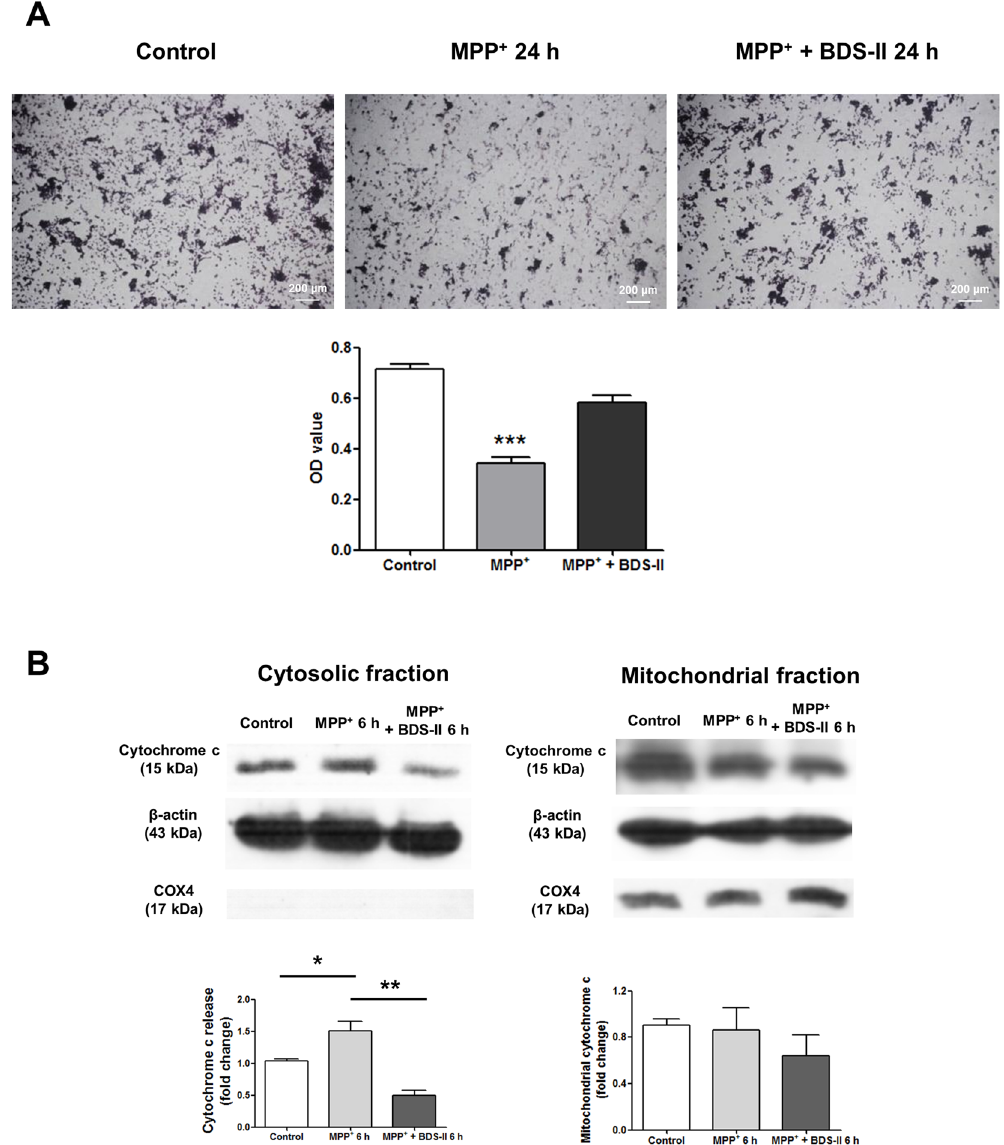
Figure 6. The neuroprotective effect of BDS-II against MPP + -induced SH-SY5Y cell death ( A ) Hemacolor- stained SH-SY5Y cells and MTT assays demonstrate that 100 nM BDS-II protected SH-SY5Y cells against 500 µ M MPP + -induced neural cell death. The MTT assay demonstrated that only 48.23 ± 2.91% of cells survived after 24 h of 500 µ M MPP + treatment, whereas BDS-II enabled 81.68 ± 3.94% of cells to survive after 500 µ M MPP + treatment. ( B ) BDS-II blocked MPP + -induced cytochrome c release from the mitochondrial intermembrane space to the cytosol, which is a key step in the apoptosis signalling pathway. Experiments were repeated in triplicate, and data represent the mean ± standard error. * p < 0.05, ** p < 0.01, and *** p < 0.001 versus the control